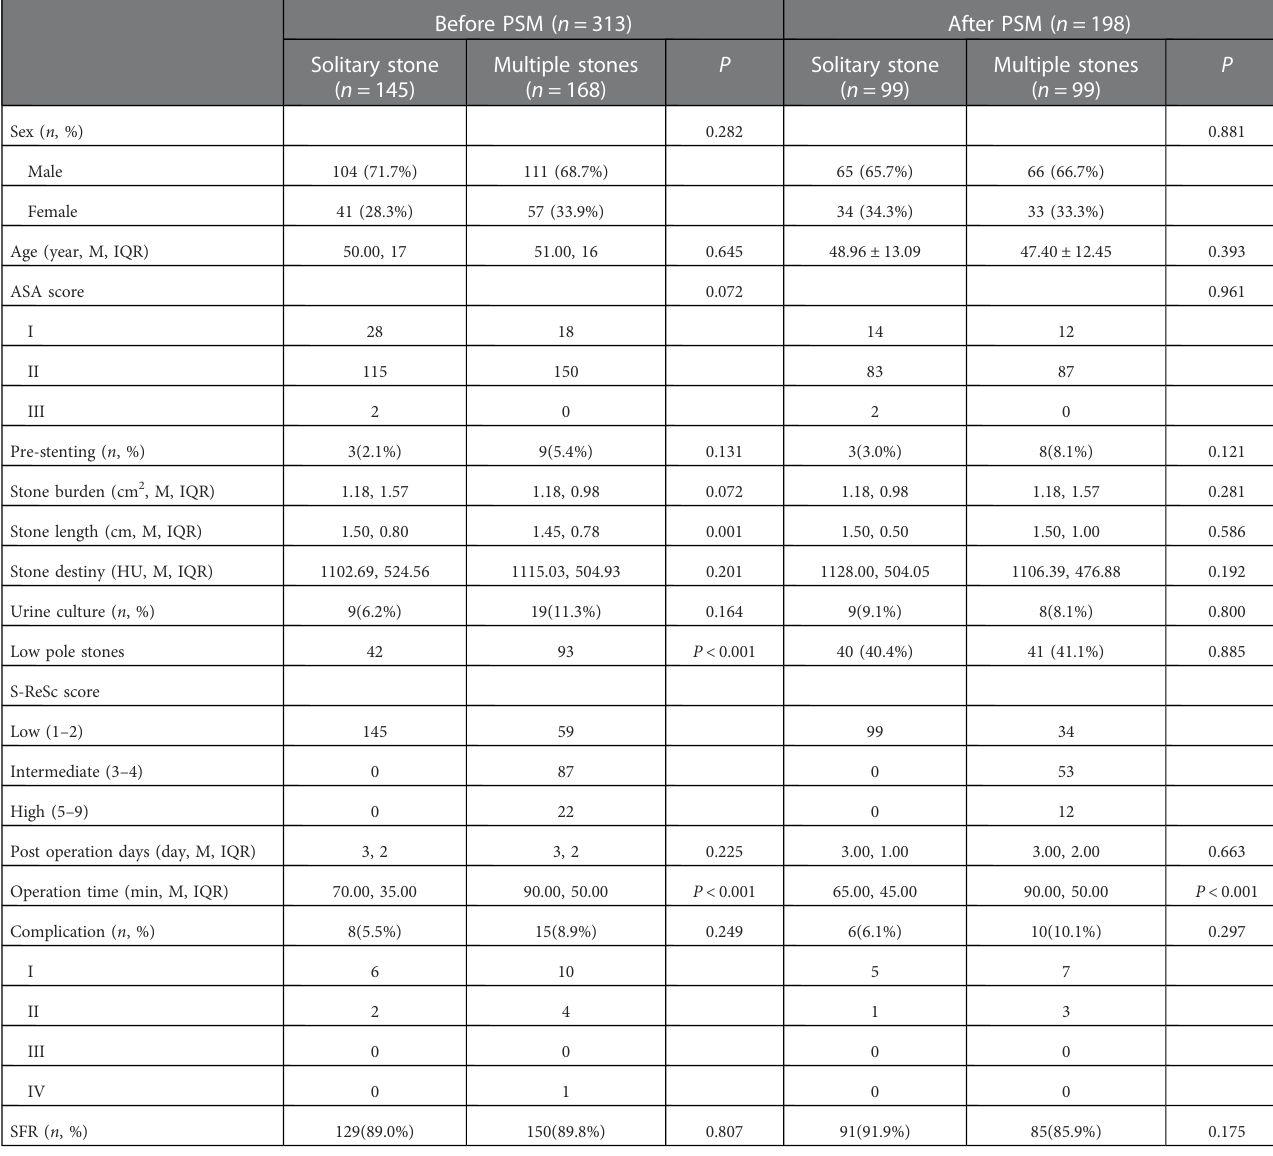
TABLE 1 Comparison of the clinical characteristics of included patients.